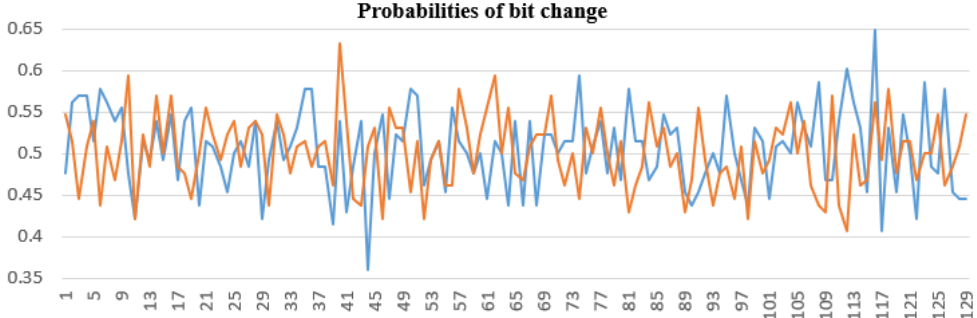
Figure 4. Results of testing the avalanche effect.